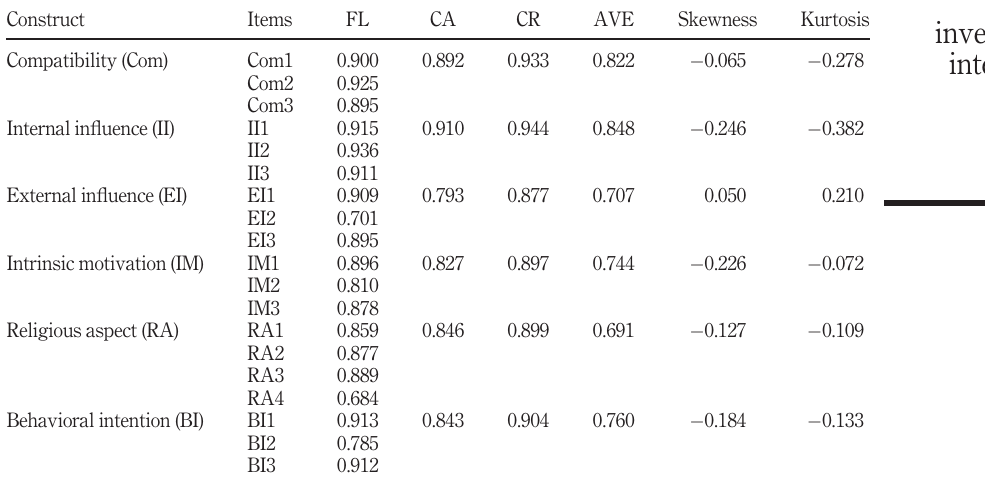
Table 2. Measurement